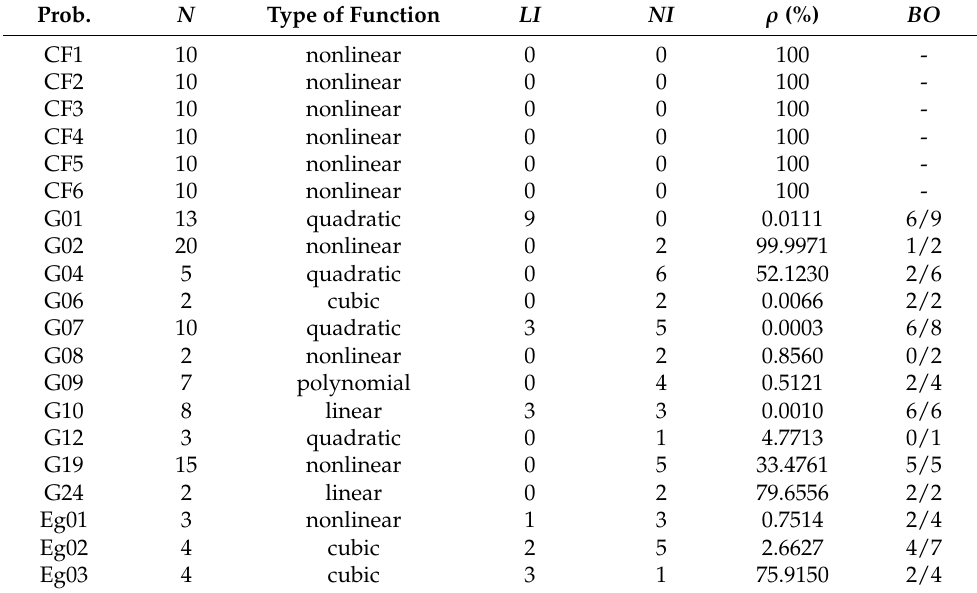
Table 2. Details of benchmark functions.